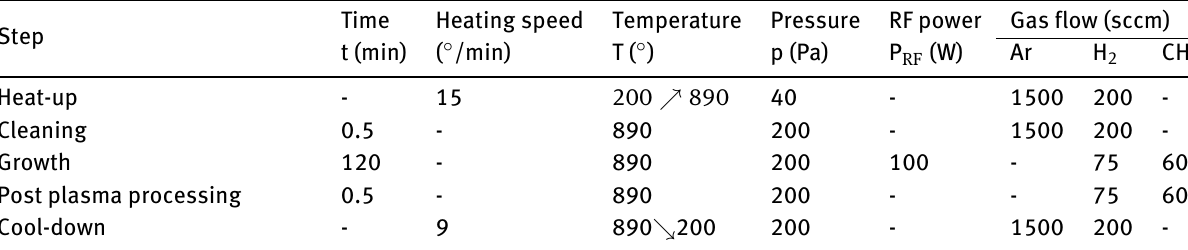
Table 1: NCG growth parameters